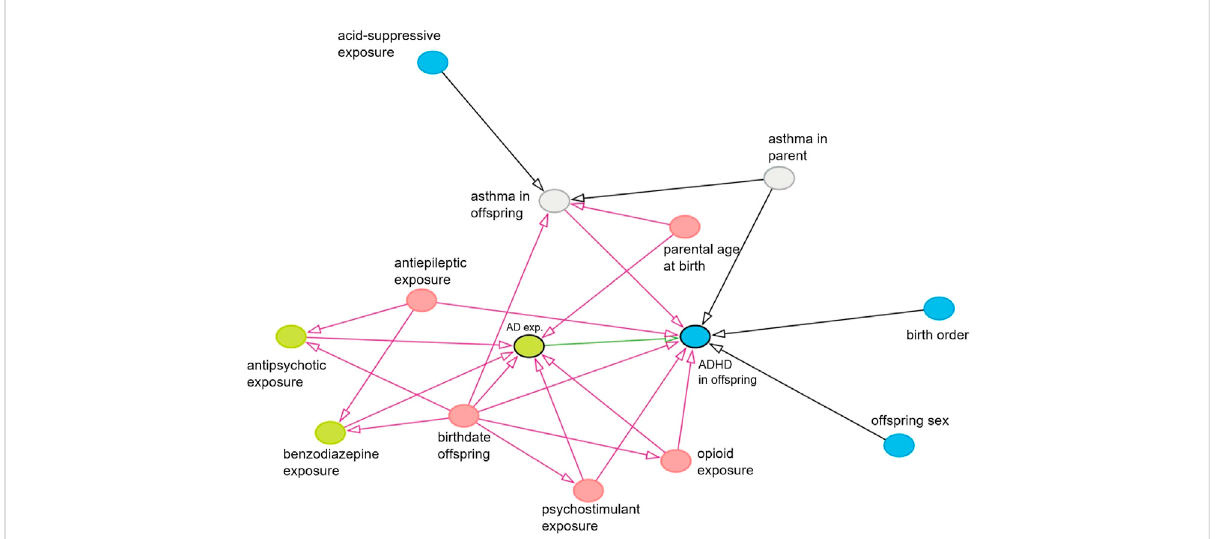
FIGURE 1 Causal diagram showing causal associations between all variables which have an association with the exposure and/or with the outcome. Only observed variables or unobserved mediators are shown. Exposure is shown in green with a black border, the effect of interest is shown as a green arrow, theoutcomeisshowninbluewith ablack border, andpotential confoundersandtheirbiasingpathsareshown inpink. Green andbluenodes are ancestors of exposure and outcome, respectively. Gray nodes are unobserved variables.